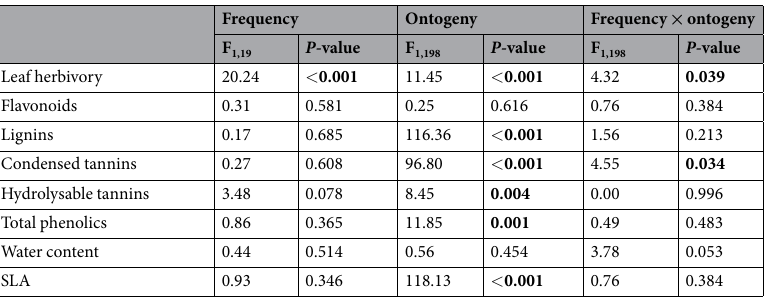
Table 1. Summary of results from mixed models testing for the effects of neighbourhood type (high- vs low- frequency of Quercus robur ), ontogenetic stage (adult trees vs. saplings) and their interaction on leaf herbivory (proportion of herbivore-damaged leaves), leaf physical traits (proportion of water content and specific leaf area [SLA]) and concentration of leaf chemical defences (flavonoids, lignins, condensed and hydrolysable tannins and total phenolics) in Q. robur . Herbivory was estimated as the proportion of leaves damaged by insect herbivores for two randomly chosen low-hanging branches. Herbivory data were logit-transformed to achieve normality of residuals. Site and site × neighbourhood type were included as random factors. F-values, degrees of freedom and associated P -values of fixed factors are reported. Significant P -values ( P < 0.05) are typed in